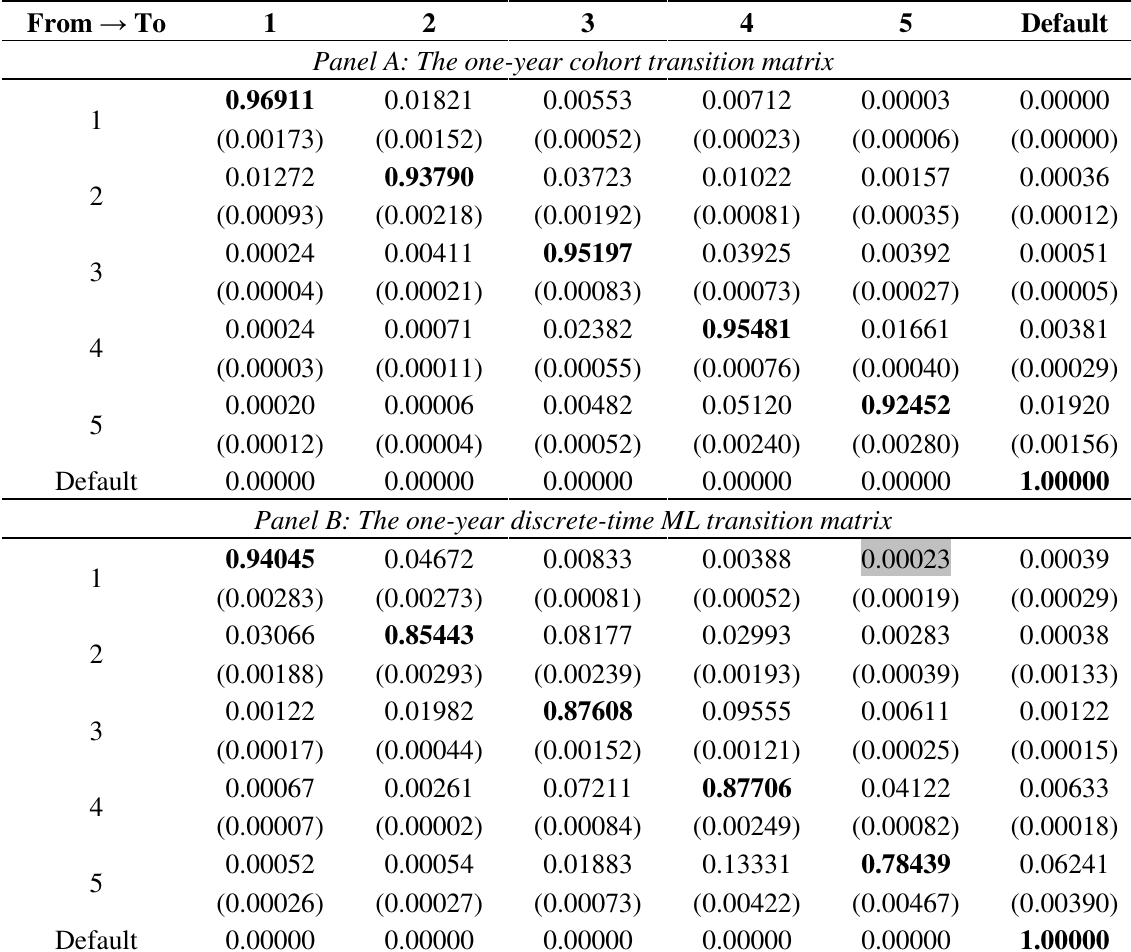
Table 1. Transition probabilities in time-homogeneity: Full